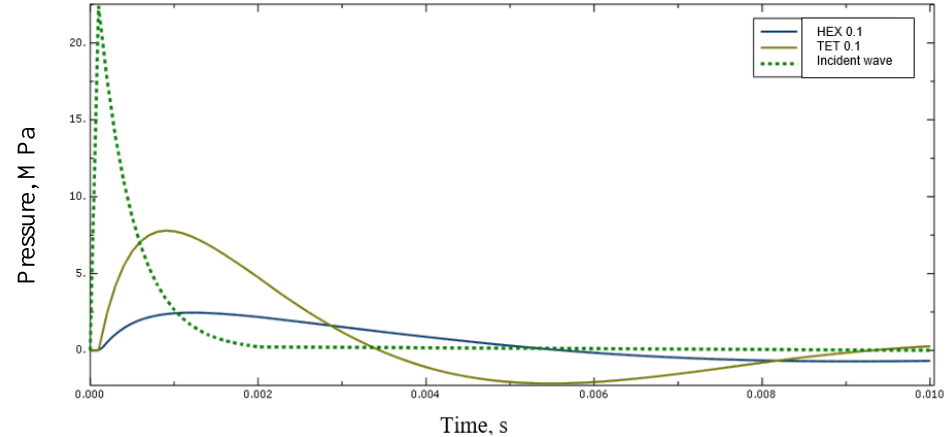
Figure 11. Pressure values on the front of a shock wave at the measuring point for acoustic elements with a size of 0.10 m (TET — tetragonal elements, HEX — hexagonal elements). Appl. Sci. 2020 , 10 , x FOR PEER REVIEW